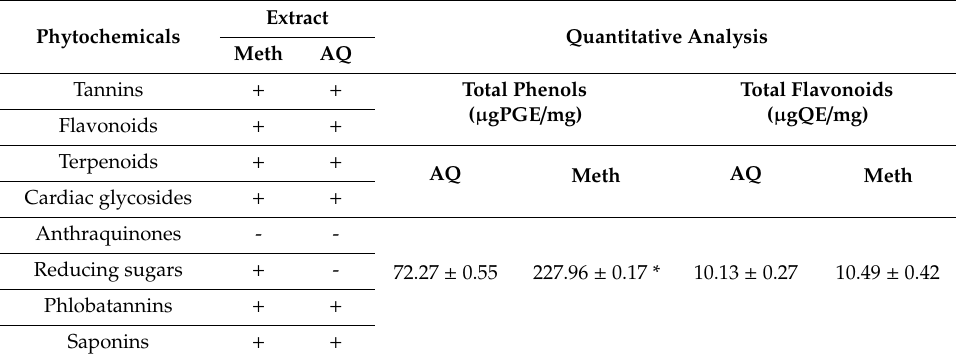
Table 1. Qualitative and quantitative assessment of C. lanceolatus stem